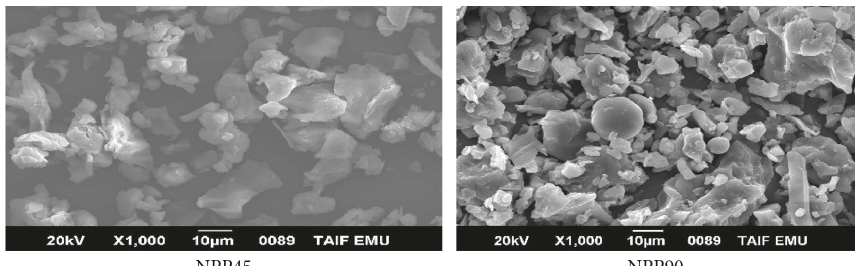
Figure 3: SEM of nano-pomegranate peel fractions (NPP45 and NPP90).